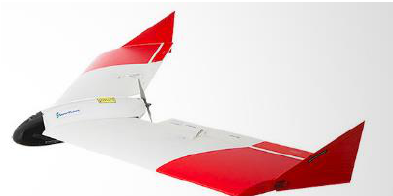
Figure 1. SmartOne UAV [http://smartplanes.se/] UAV image acquisition area is over the campus of Inha University of Korea. The area contains mostly flat ground with a few campus buildings on the boundary of the area.